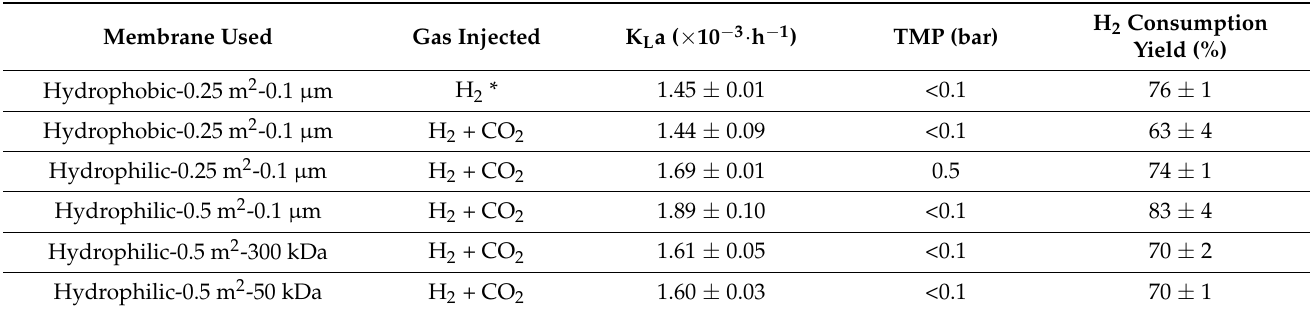
Table 2. Effect of H 2 partial pressure, membrane hydrophobicity, and surface and pore size on gas-to-liquid